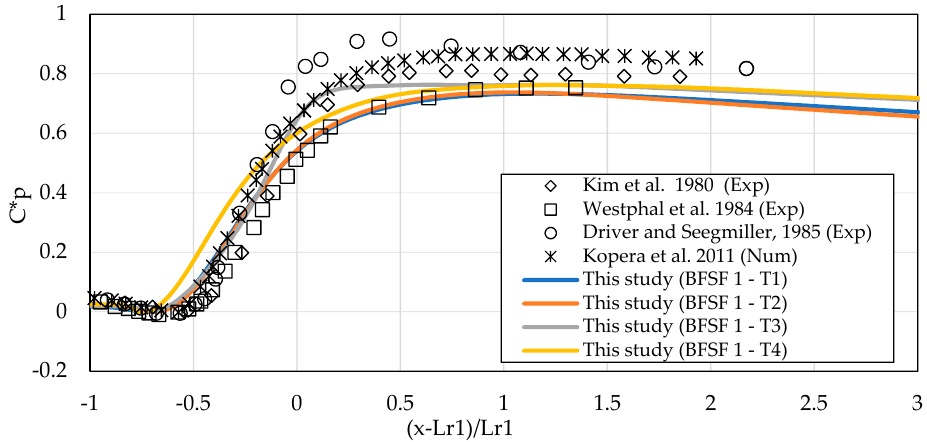
Figure 13. Longitudinal normalized pressure coefficient (C* p ) at the bottom wall downstream of the step, [30,39,66,67].